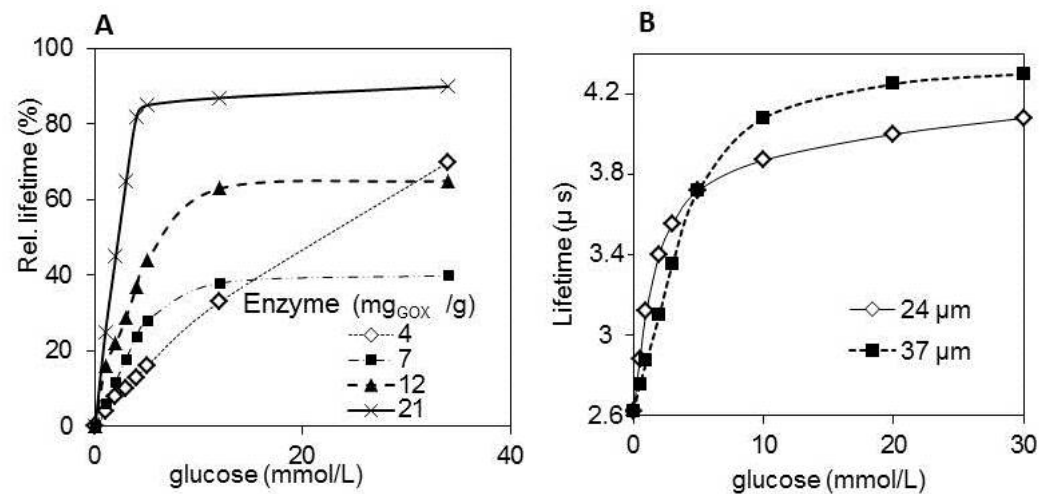
Figure 13. Optical fiber sensor of glucose for bioreactors. The influence of thickness of recognition layer on the sensor response ( A ); The influence of Glucose oxidase enzyme (GOX, E.C. 1.1.3.4.) content (Enzyme loading on the carrier: 75 mg GOX/g Sepabeds ® ) ( B